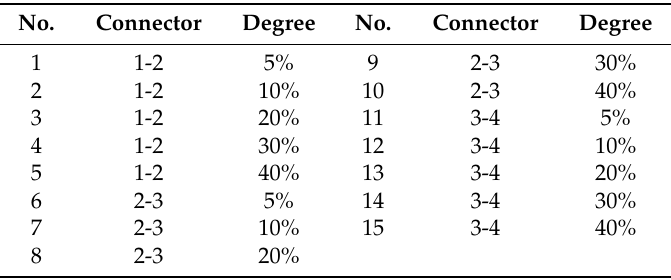
Table 3. Setup of disc space variation (DSV) fault in middle 10-disk